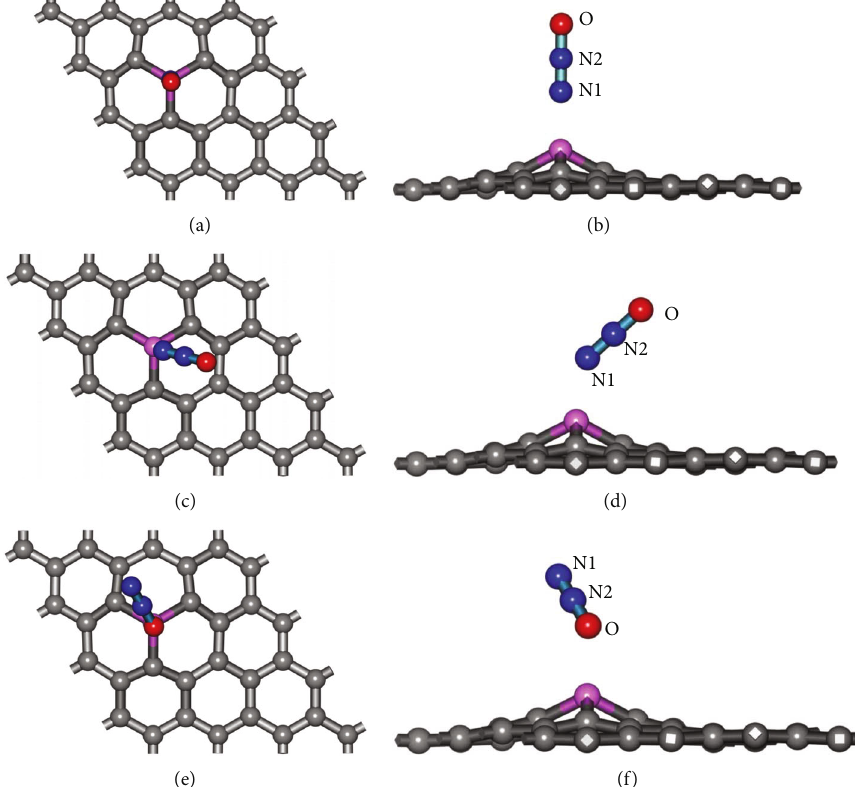
Figure 8: Adsorption con fi guration of N view; (e) M3 top view; (f) M3 side view).